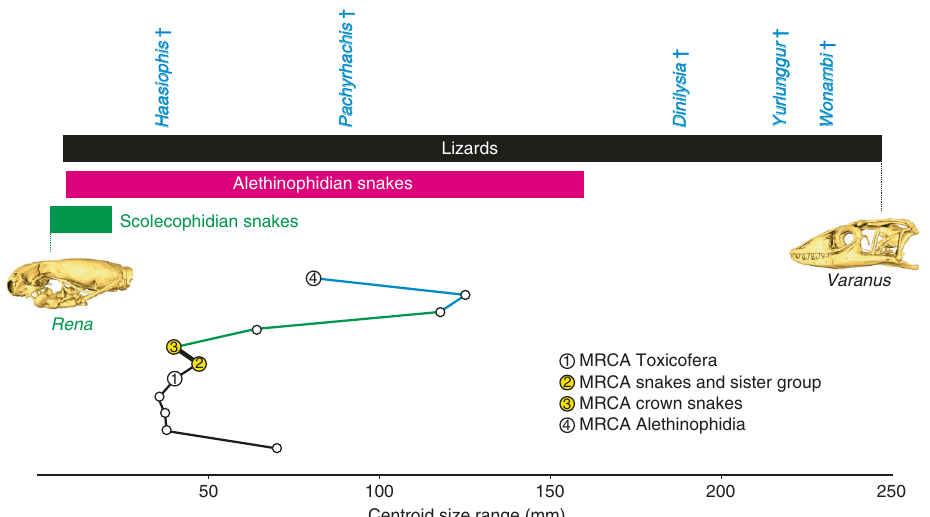
Fig. 5 Origin and diversi fi cation of skull size in snakes. Centroid size variation of skulls for both extant and fossil species were mapped onto the phylogeny presented in Fig. 1, and ancestral estimation for each internal node was performed using squared-change parsimony. For clarity, mosasaur genera are not shown because of their gigantic size, and only phylogenetic tree branches connecting major internal nodes (as in Fig. 1) are drawn. The centroid size range of lizards, scolecophidians, and alethinophidians, as well as the exact position of fossils are indicated on top as reference (with color code as in Fig. 1). 3D- rendered adult skulls of extant species with extreme centroid size values ( Rena and Varanus , position indicated with colored lines) are